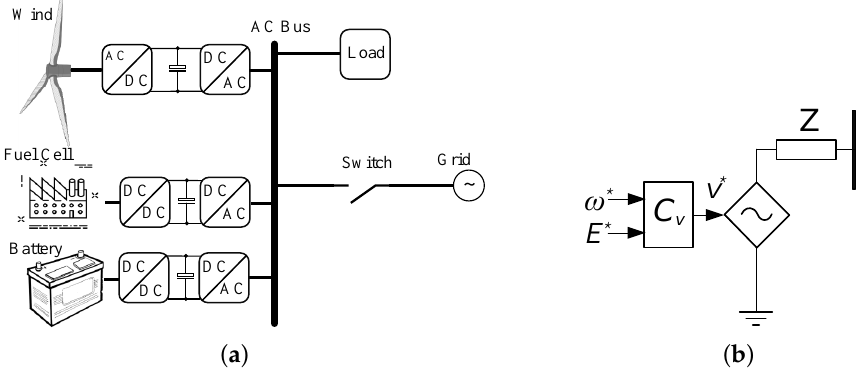
Figure 1. ( a ) Schematic representation of an islanded microgrid; and ( b ) the electrical model of the